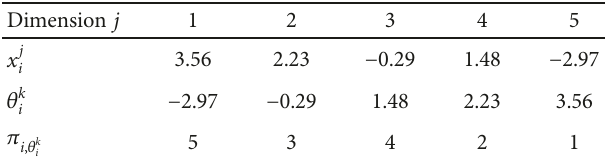
to sequence of i